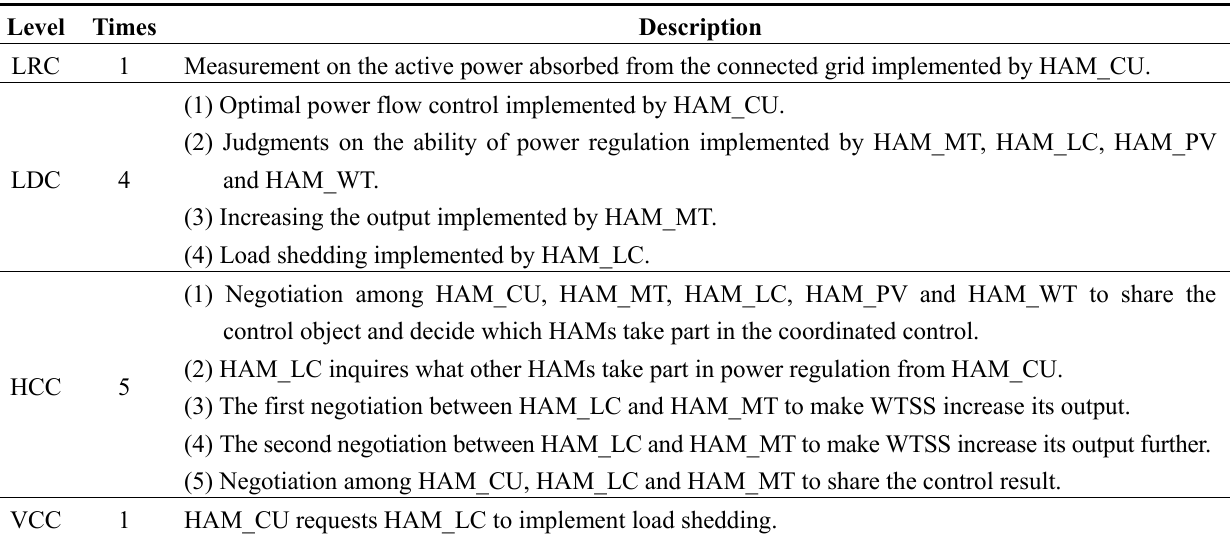
Table 4. Summary of controls implemented in Scenario